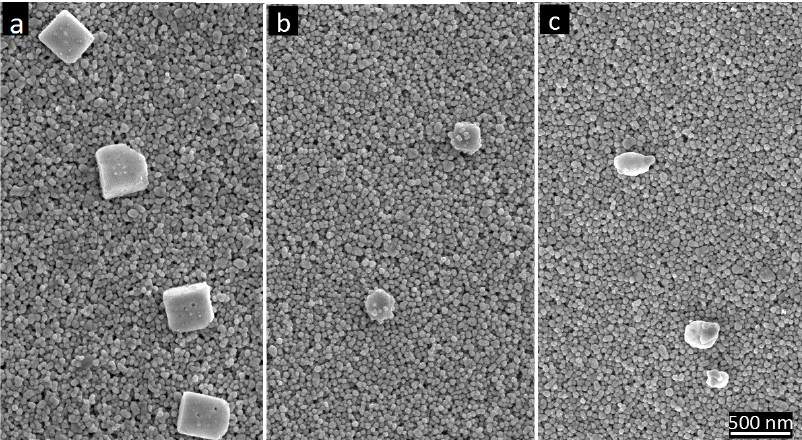
Figure 6. AgCl formation on top of the AgNP films (SEM images). ( a ) HP22 reference (pretreated with 0.3 M KCl), ( b ) HP10 active, and ( c ) HP22 active papers.